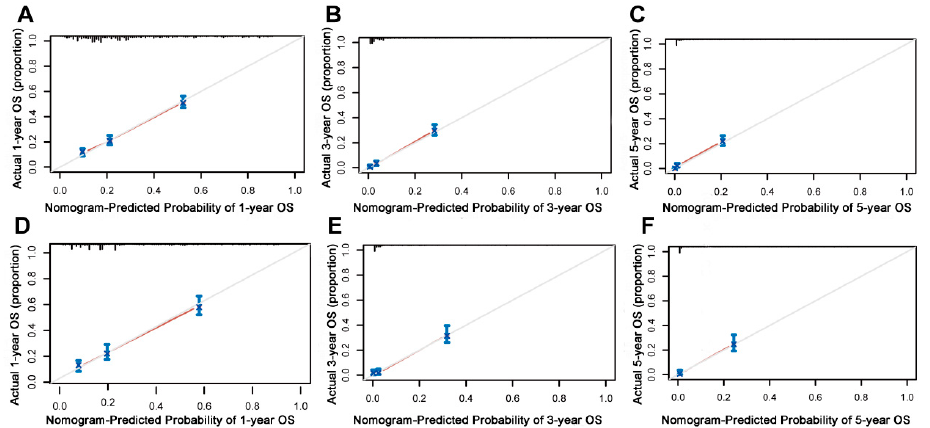
Figure 5. Calibration curves of the prognostic nomogram model. ( A – C ) Calibration curves for the 1-year, 3-year, and 5-year overall survival of patients with liver metastases from pancreatic cancer in the training cohort and ( D – F ) validation cohort. The black line represents the ideal reference line, and the blue line is calculated by bootstrapping (resampling: 1000) and represents the nomogram performance. The closer the solid red line is to the black line, the more accurate the model is at predicting overall survival.